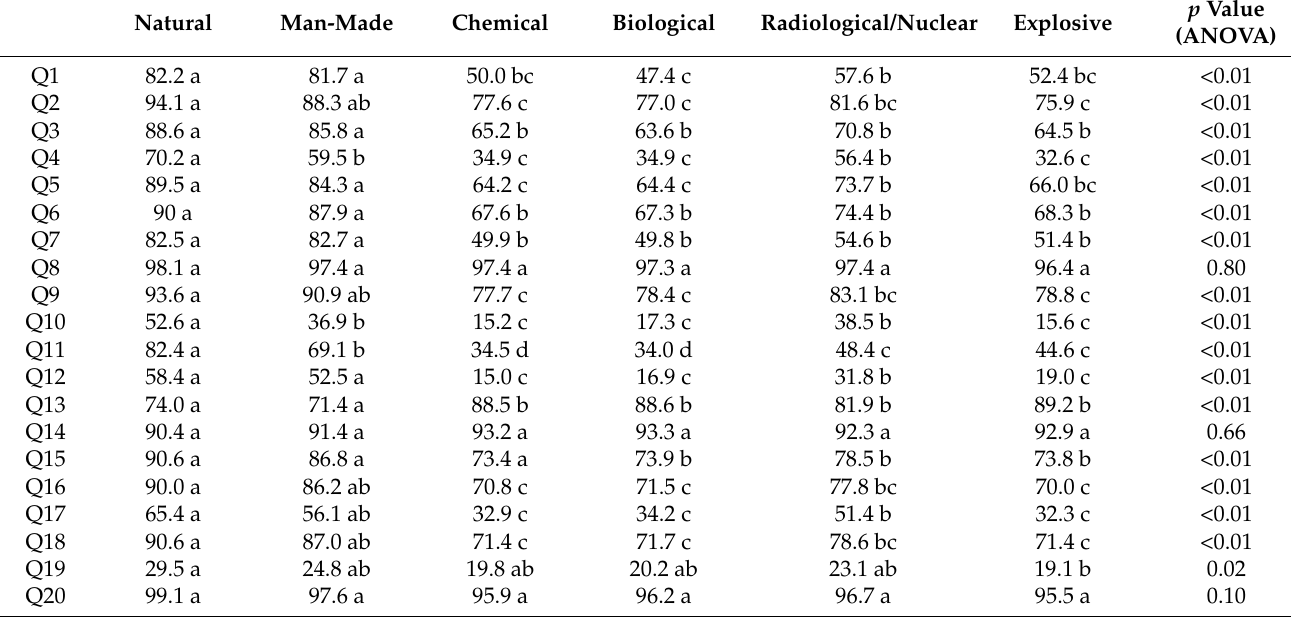
Table A1. Average Scores for Survey Questions for Each Hazard.